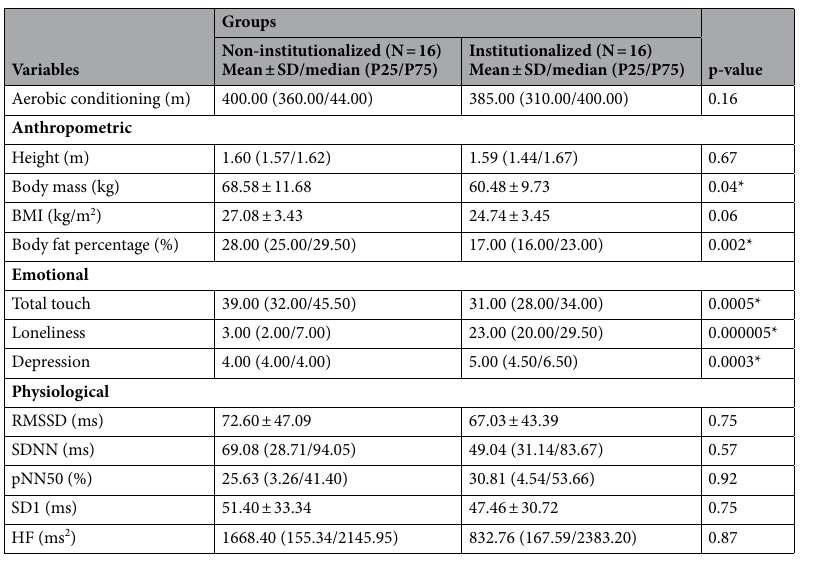
Table 1. Characteristics of the sample before the intervention. N number of individuals, SD standard deviation, P25 25th percentile, P75 75th percentile, Kg kilogram, BMI body mass index, cm centimeters, m meters, kg/m 2 kilogram per square meter, RMSSD root mean square of the successive differences between the RR intervals, SDNN standard deviation of all RR intervals, pNN50 percentage of successive differences between the RR intervals that are > 50 ms, SD1 standard deviation 1, ms milliseconds. *Significant difference between the groups (*p <